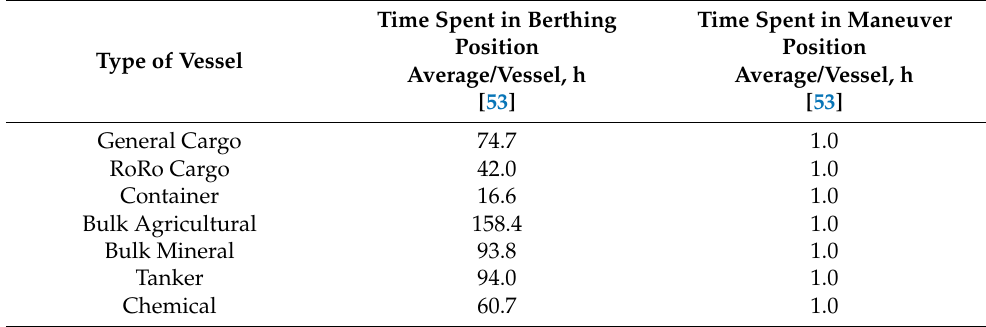
Table 8. Time spent in berthing position (h) by type of vessel in the port of Veracruz.